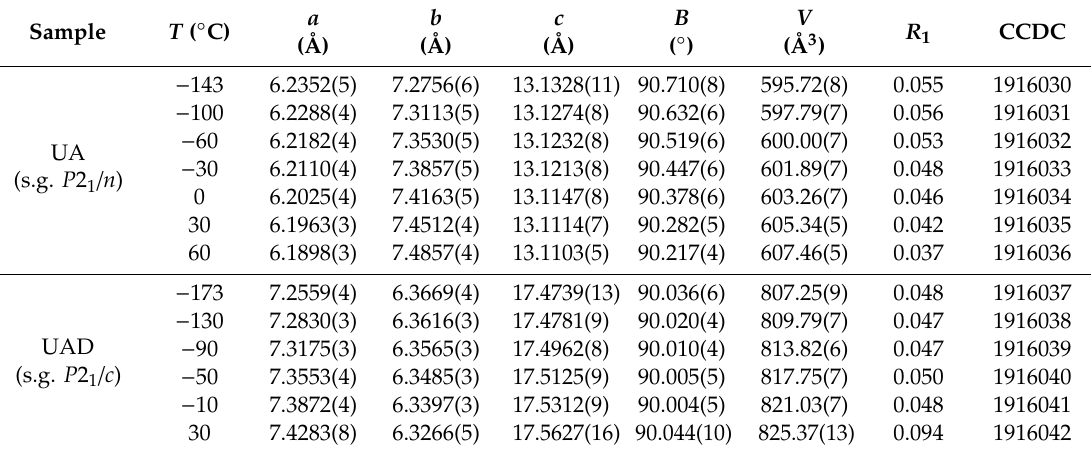
Table 1. Crystallographic data and refinement parameters for UA and